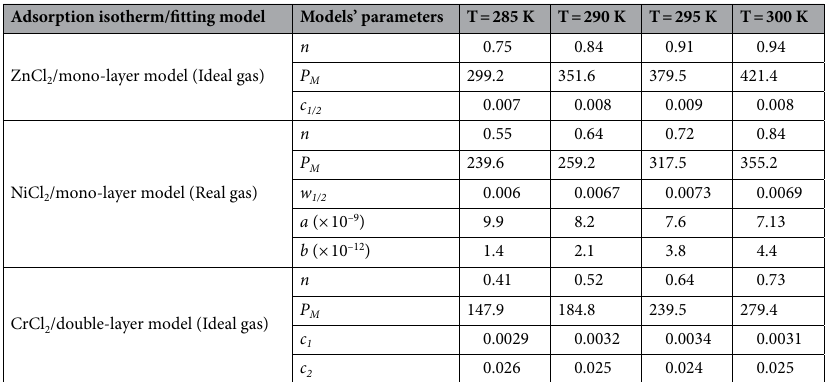
Table 5. Fitting values of the physicochemical parameters ( n, P M , a, b, c 1/2 , w 1/2 , c 1 and c 2 ) deduced from the adjustment of experimental isotherms of ZnCl 2 , NiCl 2 and CrCl 2 with the three adopted models.